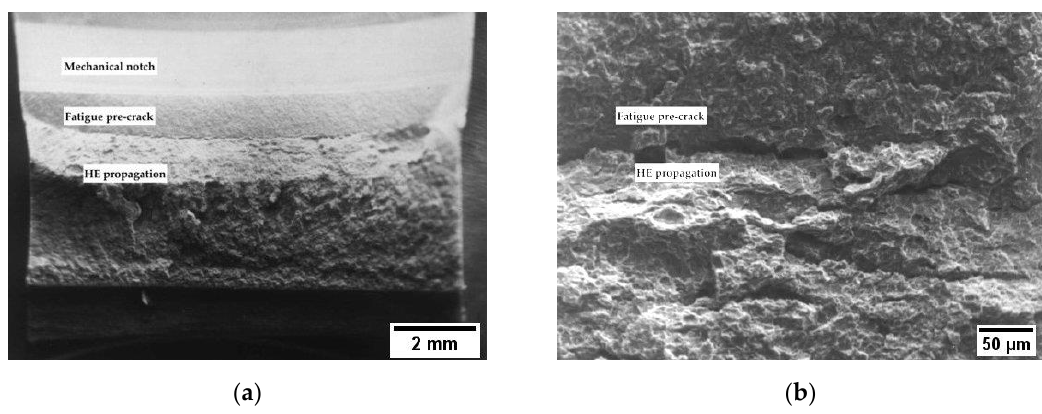
Figure 7. Fracture surface in J -integral test for X80 steel polarized at − 1 V vs. SCE: ( a ) macro and ( b ) close-up view of the fatigue pre-cracking crack propagation transition zone.